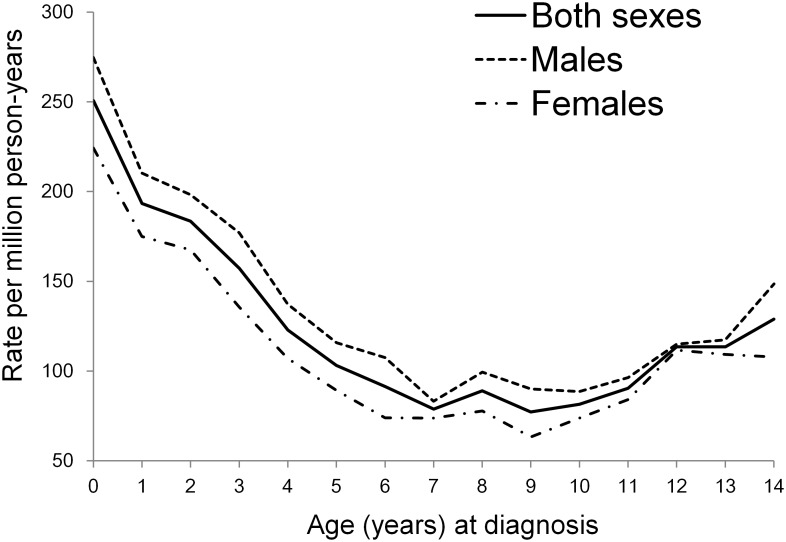
Gender-specific cancer incidence rates for children aged 0–14 years by single year of age: Taiwan, 1995–2009.